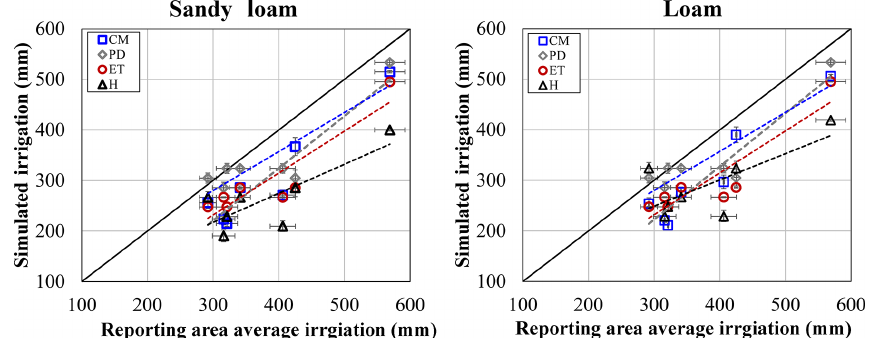
Figure 6. Historical irrigation vs. the four simulated irrigation routines for sandy loam (left panel) and loam (right panel). The vertical error bars are the standard error of the mean from the precipitation sensitivity analysis, and the horizontal error bars are the standard error of the mean from observed irrigation.